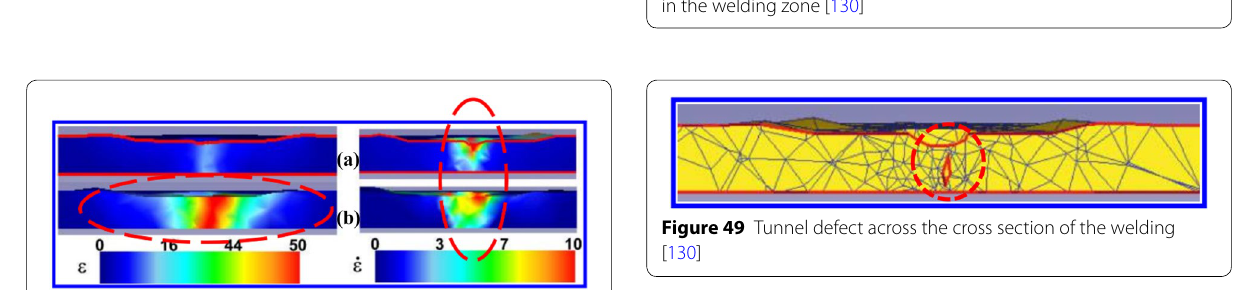
Figure 46 Relationship between the yield stress across the workpiece [132]